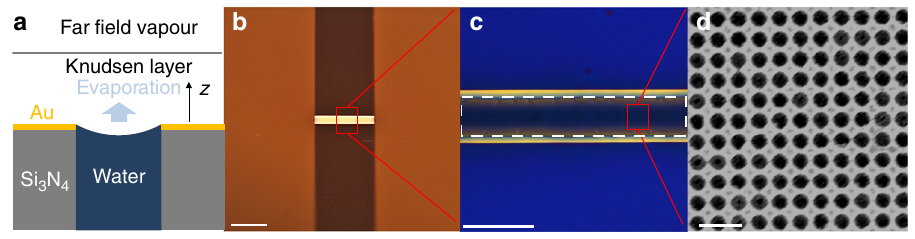
Fig. 2 Nanoporous evaporation device. a Schematic of evaporation from a nanopore (not to scale). The gold layer is resistively heated to induce evaporation from a pinned meniscus in each nanopore. b Image of device with two gold contact pads connected by a free-standing membrane (<200 nm thick). The white scale bar is 2 mm. c Magni fi ed view of free-standing membrane where the central part (white dashed box) is porous and coated with gold and the rest is impermeable and nonmetallic. The white scale bar is 500 μ m. d Scanning electron microscope image of the nanoporous membrane with ≈ 140 nm diameter pores. The white scale bar